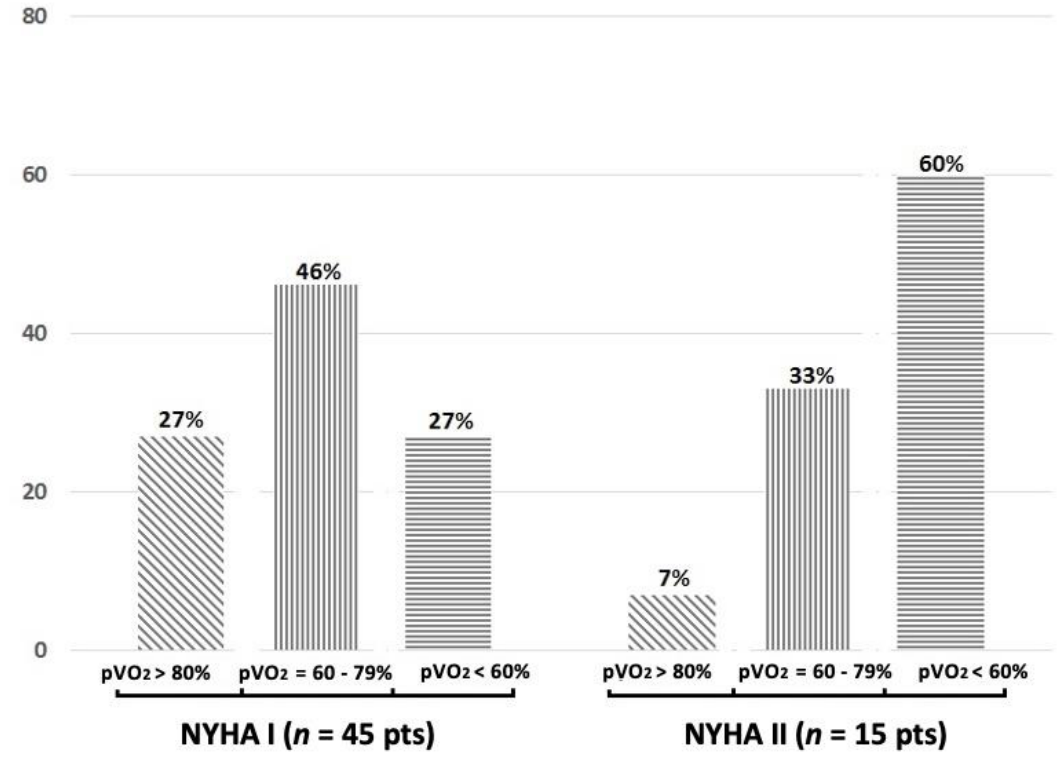
Figure 1. Prevalence of reduced exercise capacity, as assessed in terms of peak oxygen uptake (pVO 2 ) of <80% of the maximum predicted in the entire hypertrophic cardiomyopathy (HCM) study sample (panel A ) and dispersion of pVO 2 values within the same New York Heart Association (NYHA) functional class (panel B